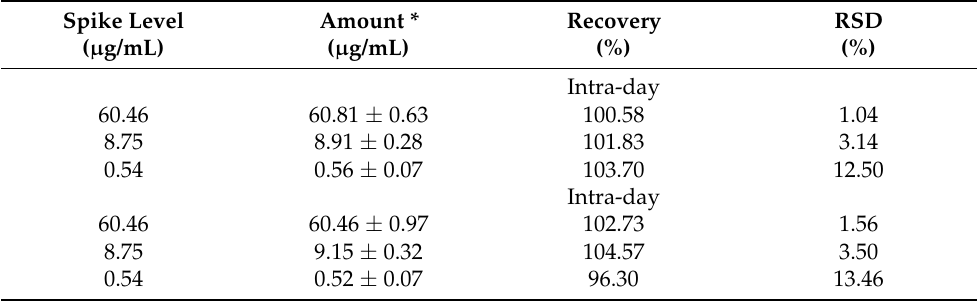
Table 3. Accuracy and precision of 2 R -LP2 determination by HPLC. RSD = relative standard deviation. * n = 6.